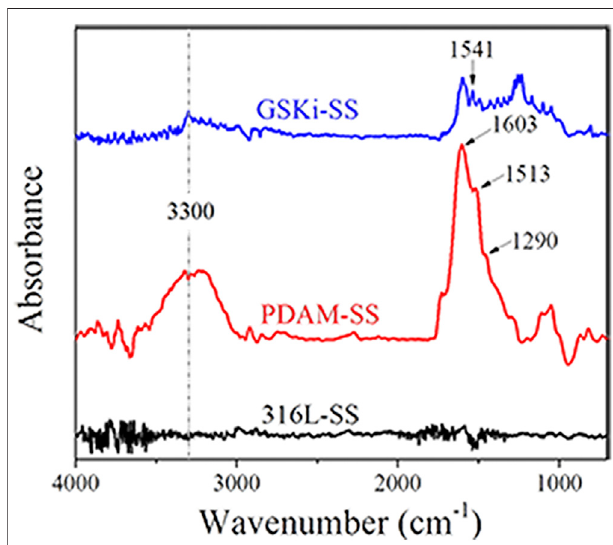
FIGURE 1 | FTIR spectra of 316L-SS, PDAM-SS and GSKi-SS.